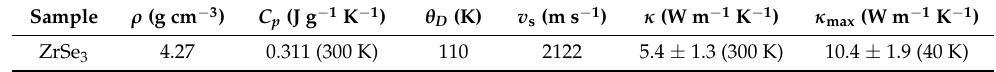
Table 1. Experimentally measured physical properties of ZrSe 3